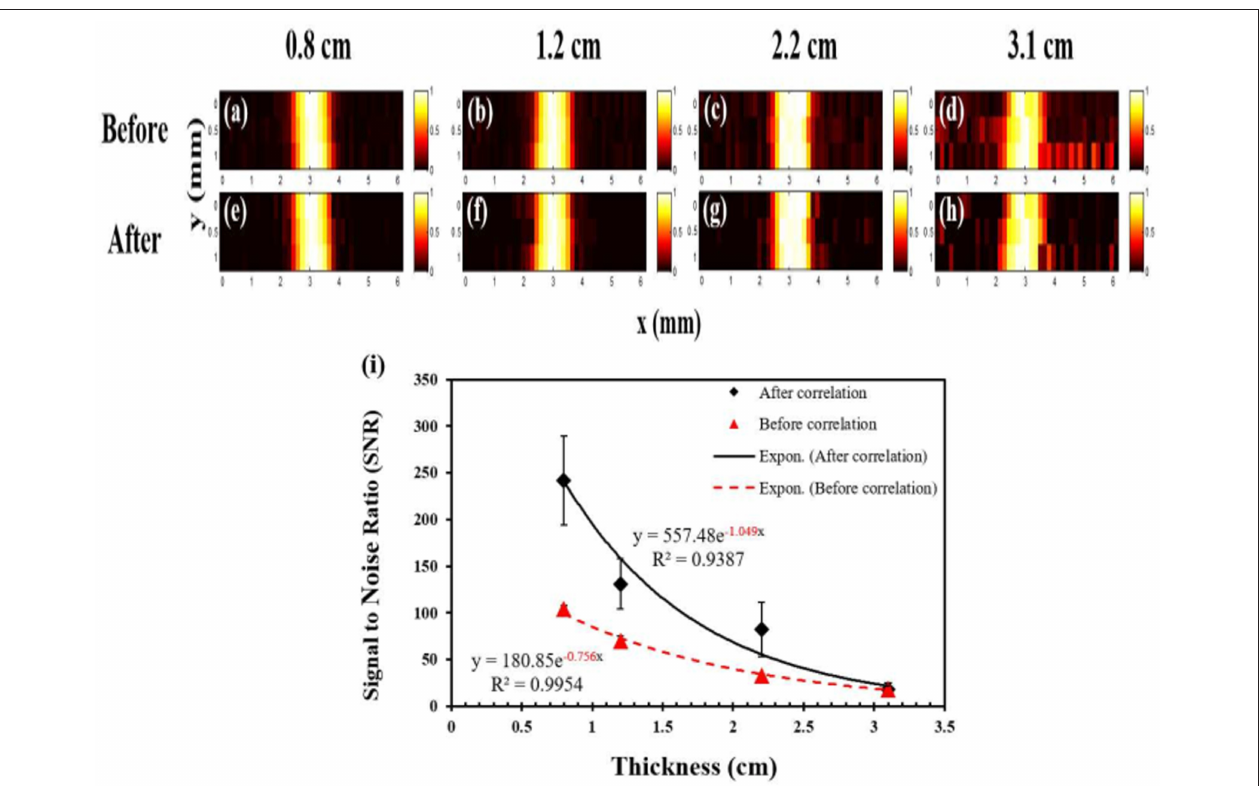
FIGURE 8 | USF images of micro-tubes in porcine muscle tissue samples (Cheng et al., 2016). (a–d) The USF images of the micro-tubes (before correlation) that were embedded into pork muscle tissue samples with thicknesses of 0.8, 1.2, 2.2, and 3.1cm, respectively. The I.D./O.D. of the tube is 0.31/0.64mm; (e–h) The corresponding USF images processed by the correlation algorithm. (a–h) scales: X axis: 0-6mm; Y axis: 0-1mm. (i) The relationship between the SNR and the thickness of the sample before (triangles) and after (diamonds) the correlation processing (error bar: mean ± standard deviation). Reproduced with permission. Copyright 2016 ©